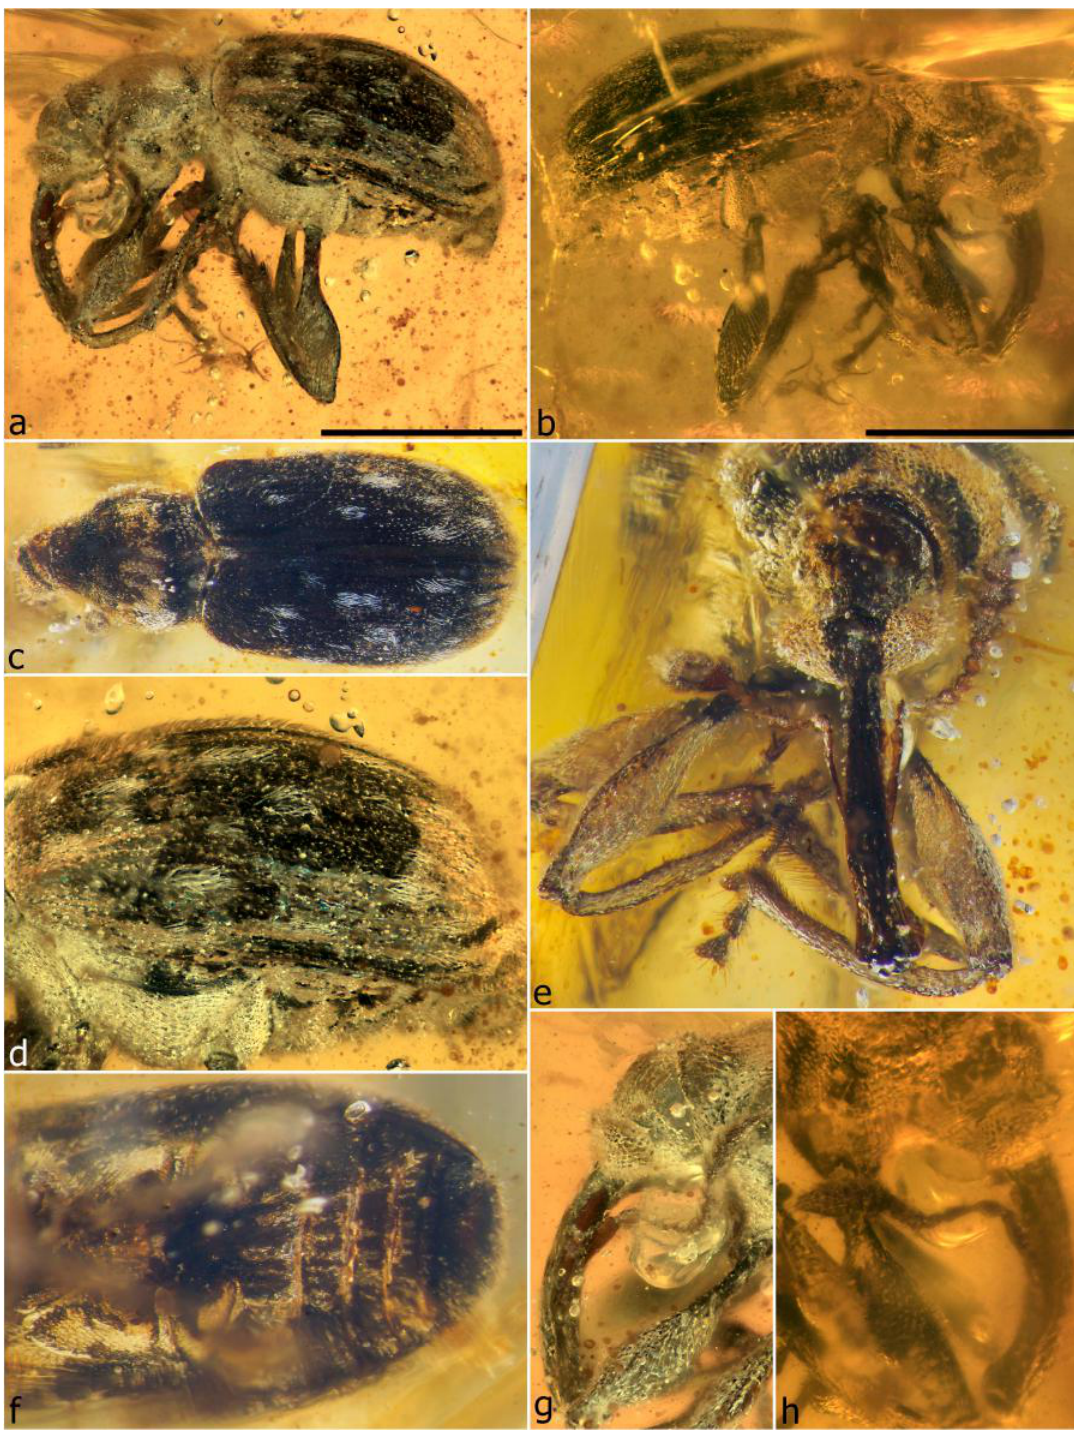
Figure 65. Compsopsarus reneae sp. n., holotype. Habitus, left lateral ( a ); habitus, right lateral ( b ); habitus, dorsal ( c ); elytra, left lateral ( d ); head, dorsal ( e ); ventrites, ventral ( f ); head and antenna, left lateral ( g ); same, right lateral ( h ). Scale bars: 1.0 mm (a,b).